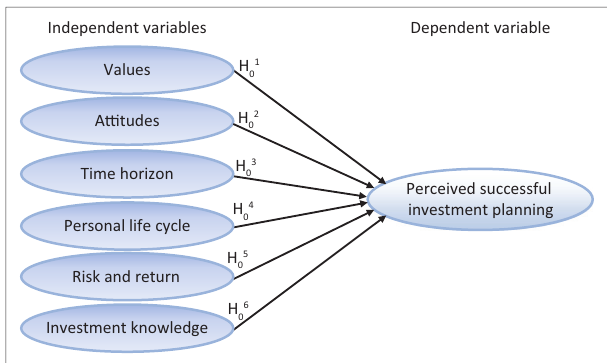
FIGURE 1: Hypothesised model of factors influencing women’s perceptions of successful investment planning